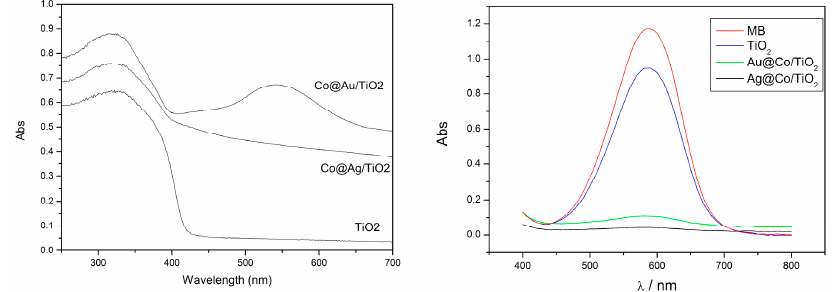
Figure 17. UV-Vis absorption spectra of TiO 2 , Co@Au/TiO 2 and Co@Ag/TiO 2 ( left ); UV-Vis absorption spectra of MB before and after degradation with TiO 2 , Co@Au/TiO 2 and Co@Ag/TiO 2 for 15 min at room temperature ( right ) [32].